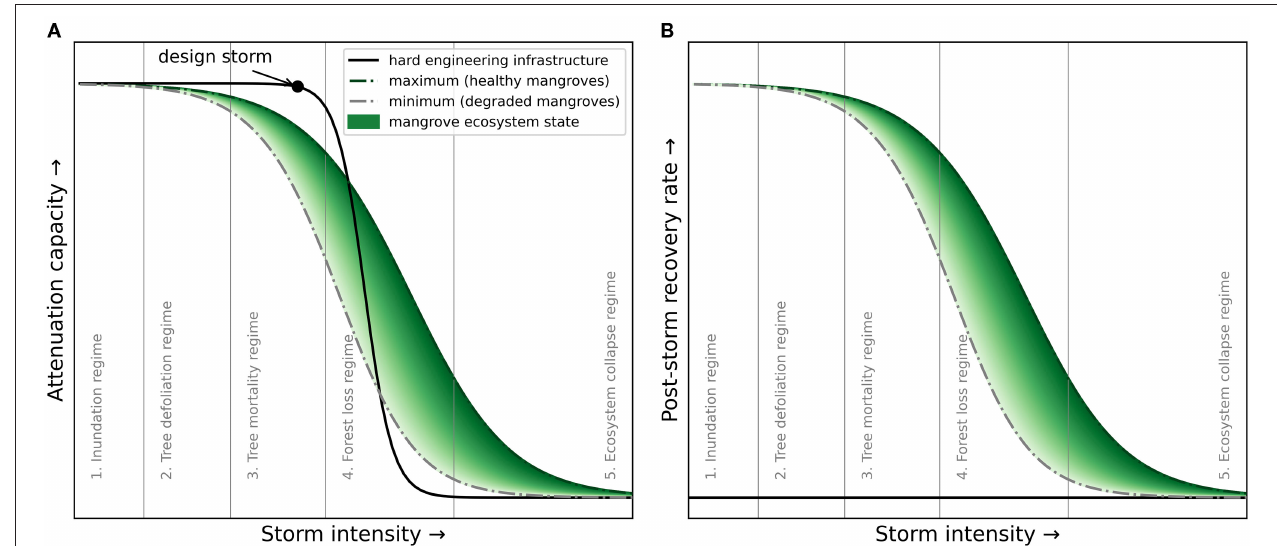
FIGURE 6 | (A) Attenuation capacity of hard-engineering infrastructure and mangroves in relation to the intensity of storms and (B) the post-storm recovery rate of mangroves in relation to the storm intensity. The attenuation capacity of hard-engineering infrastructure reduces rapidly due to failure when the design storm intensity is exceeded. The attenuation capacity of mangroves reduces gradually depending on a range of site-specific thresholds-related failure mechanisms, the mangrove ecosystem state (i.e., health) and capacity to attenuate waves. Hard-engineering infrastructure cannot recover from storm damage, but mangroves can recover depending on the intensity of damage and the ecosystem state, amongst other site-specific conditions. Generally applicable storm-impact regimes (section 2.3) are indicated, but site-specific processes and thresholds need to be determined to apply mangroves in flood risk